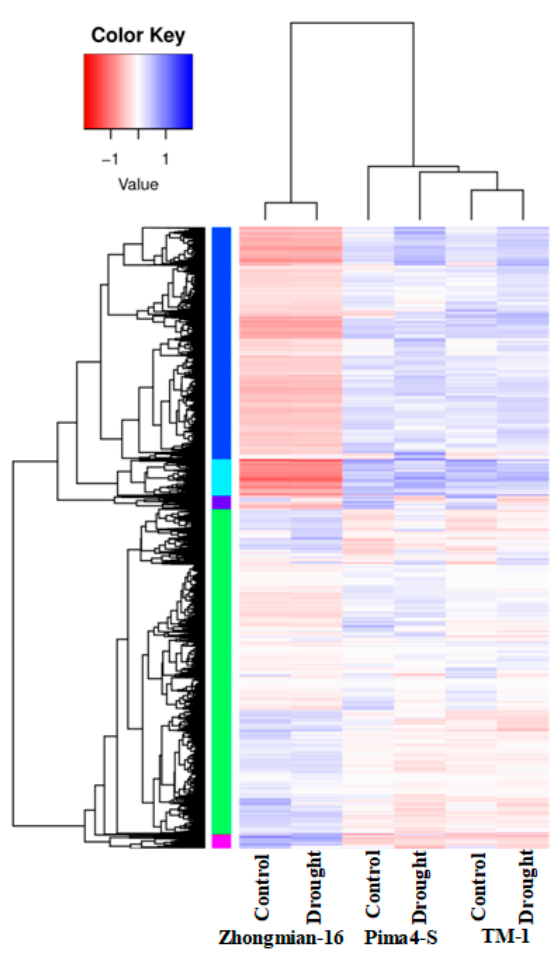
Figure 3. Transcript levels of differentially expressed genes (DEGs) in three cotton species under drought stress condition in heat maps. Heat map of all DEGs, columns, and rows in heat maps represent samples and DEGs, respectively. Blue color indicates up-regulated and red color indicates down-regulated ( p < 0.05).